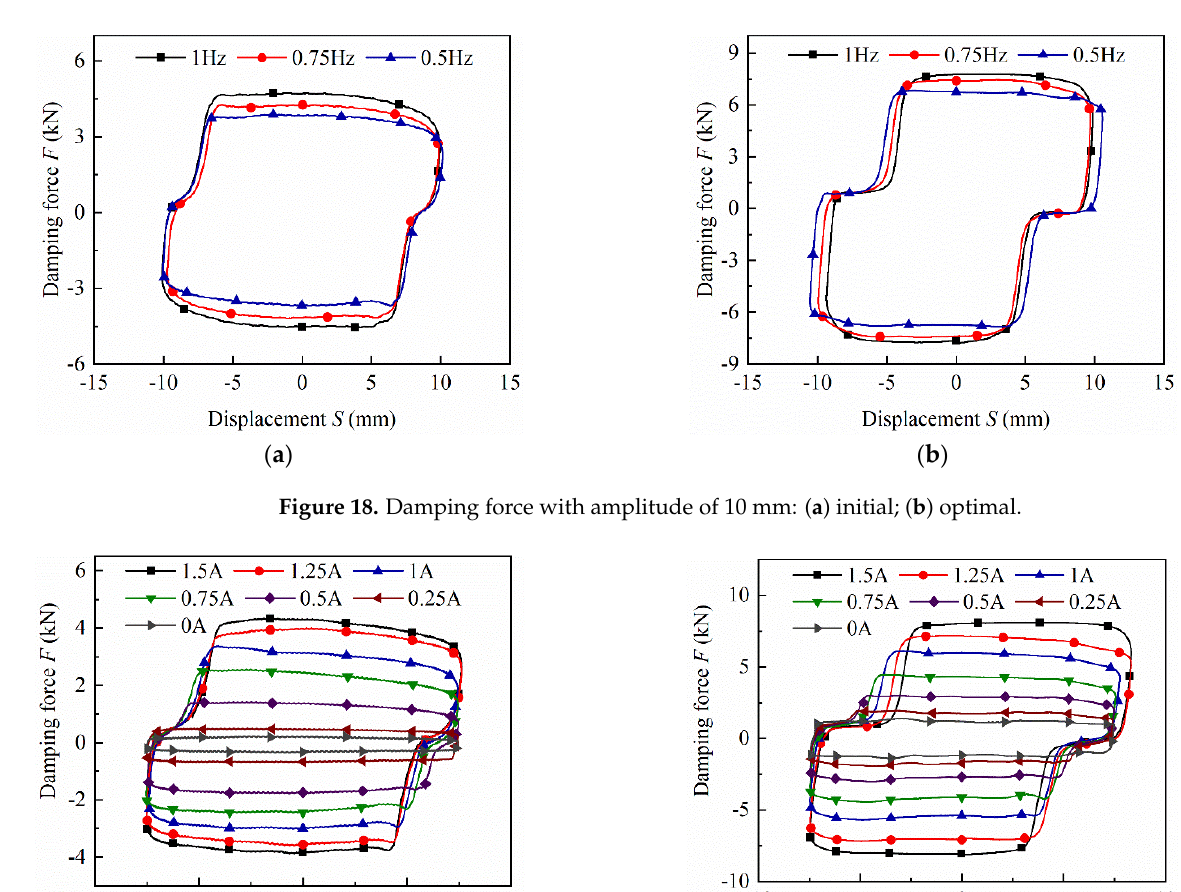
Figure 17. Damping force with amplitude of 7.5 mm: ( a ) initial; ( b ) optimal.